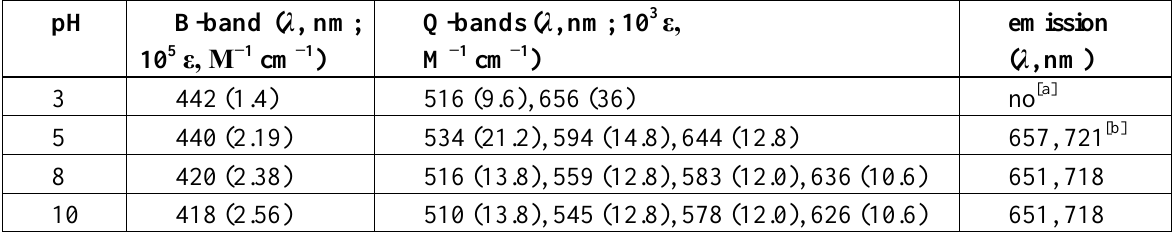
Table 1. UV/vis Absorption and Fluorescence Emission Data for OctaPhosPor 1 under Different pH Conditions in